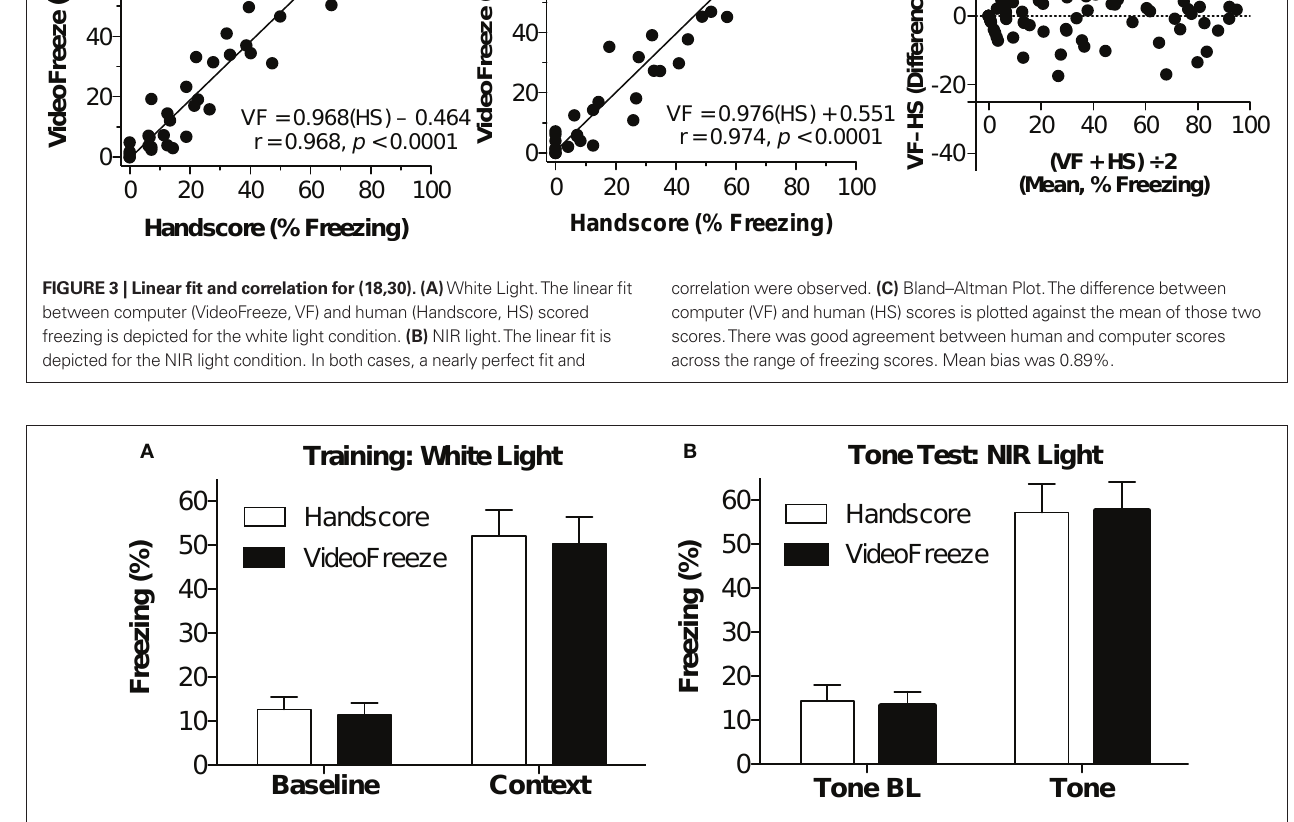
Figure 4 | Comparison of mean freezing for (18,30). (A) Training. Freezing observed by humans and VideoFreeze is depicted for the baseline (first 2 min) during the training day and post-shock freezing (Context, last 3 min). (B) Tone